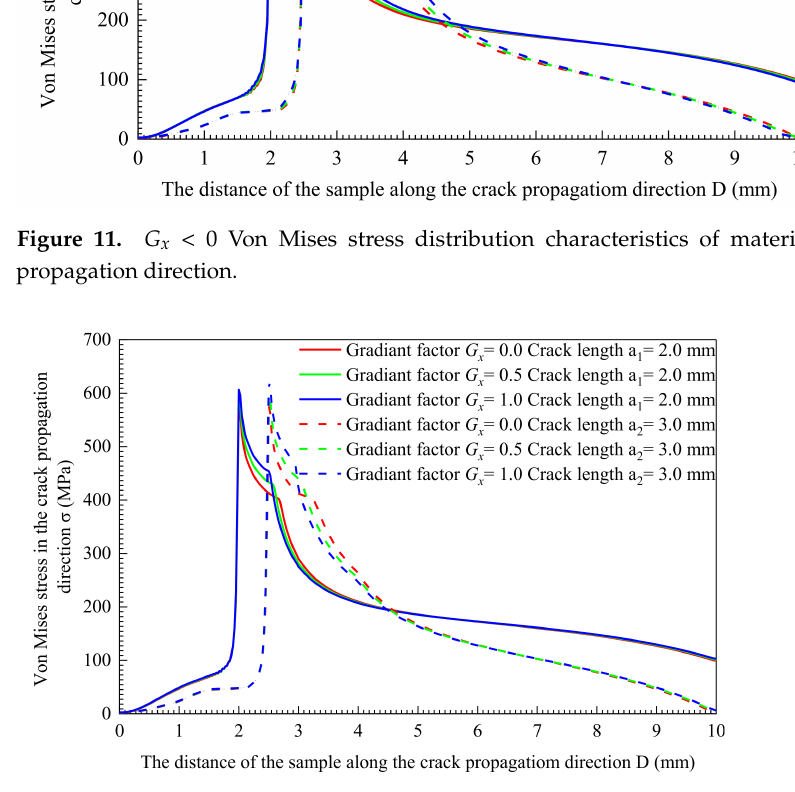
Figure 12. G x > 0 Von Mises stress distribution characteristics of materials along the crack propagation direction.